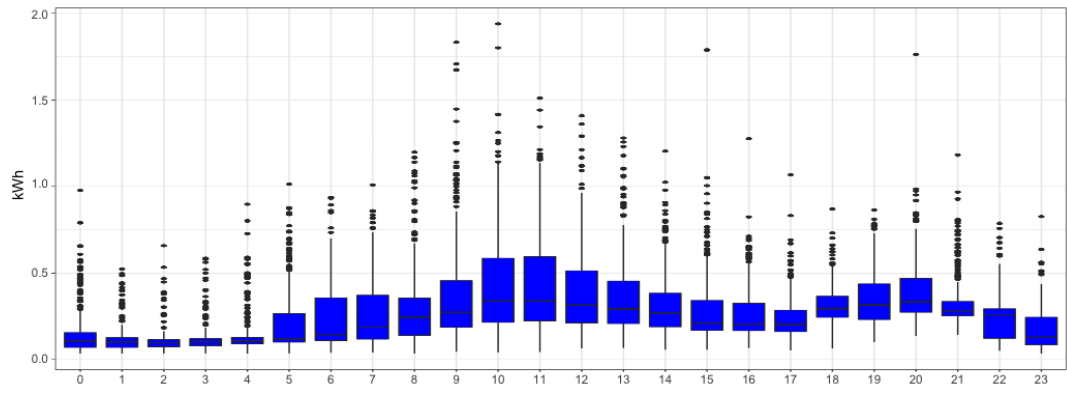
Figure 5. Daily consumption per hour for smart-meter 92 along 2013.